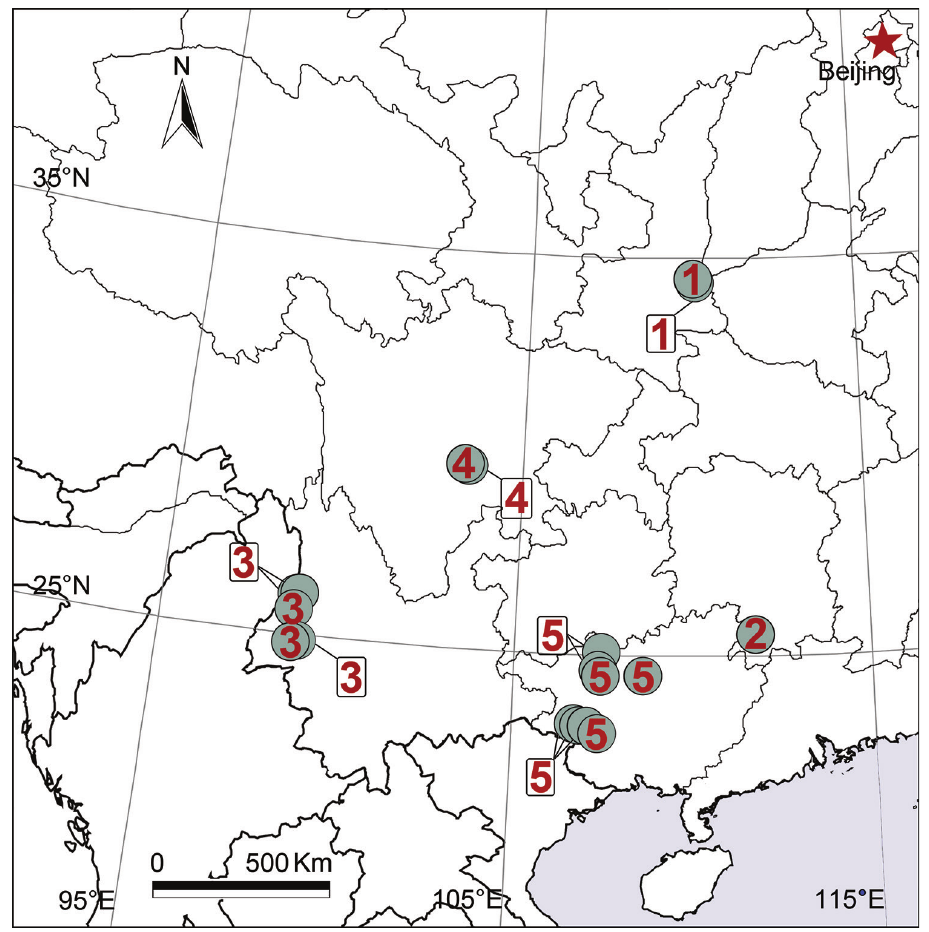
Figure 11. Collection localities of five Pireneitega species from China. 1 P. huashanensis sp. n. 2 P. liansui 3 P. lushuiensis sp. n. 4 P. triglochinata 5 P. xiyankouensis sp.